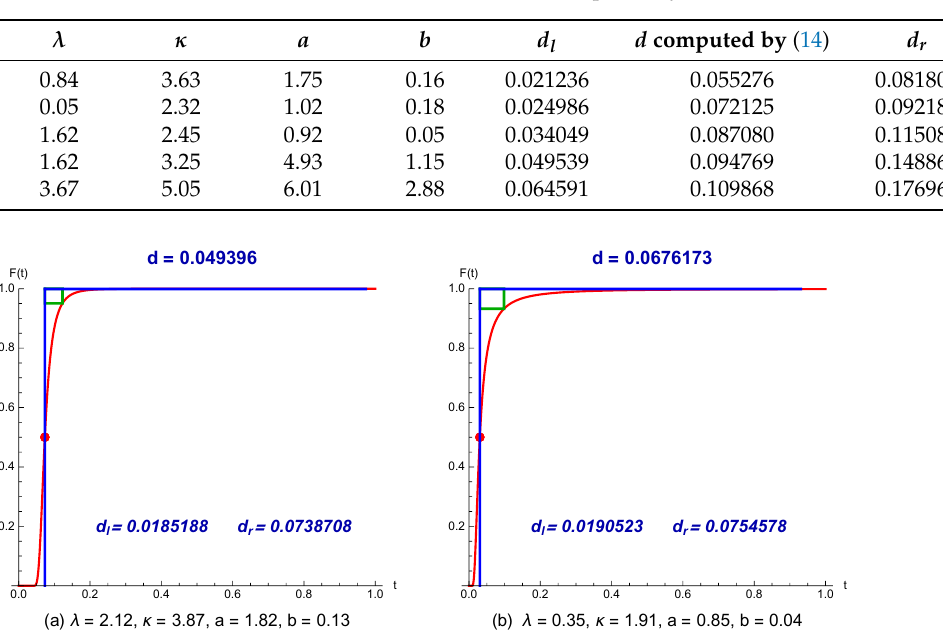
Table 4. Bounds for the one-sided Hausdorff distance d computed by Theorem 5.